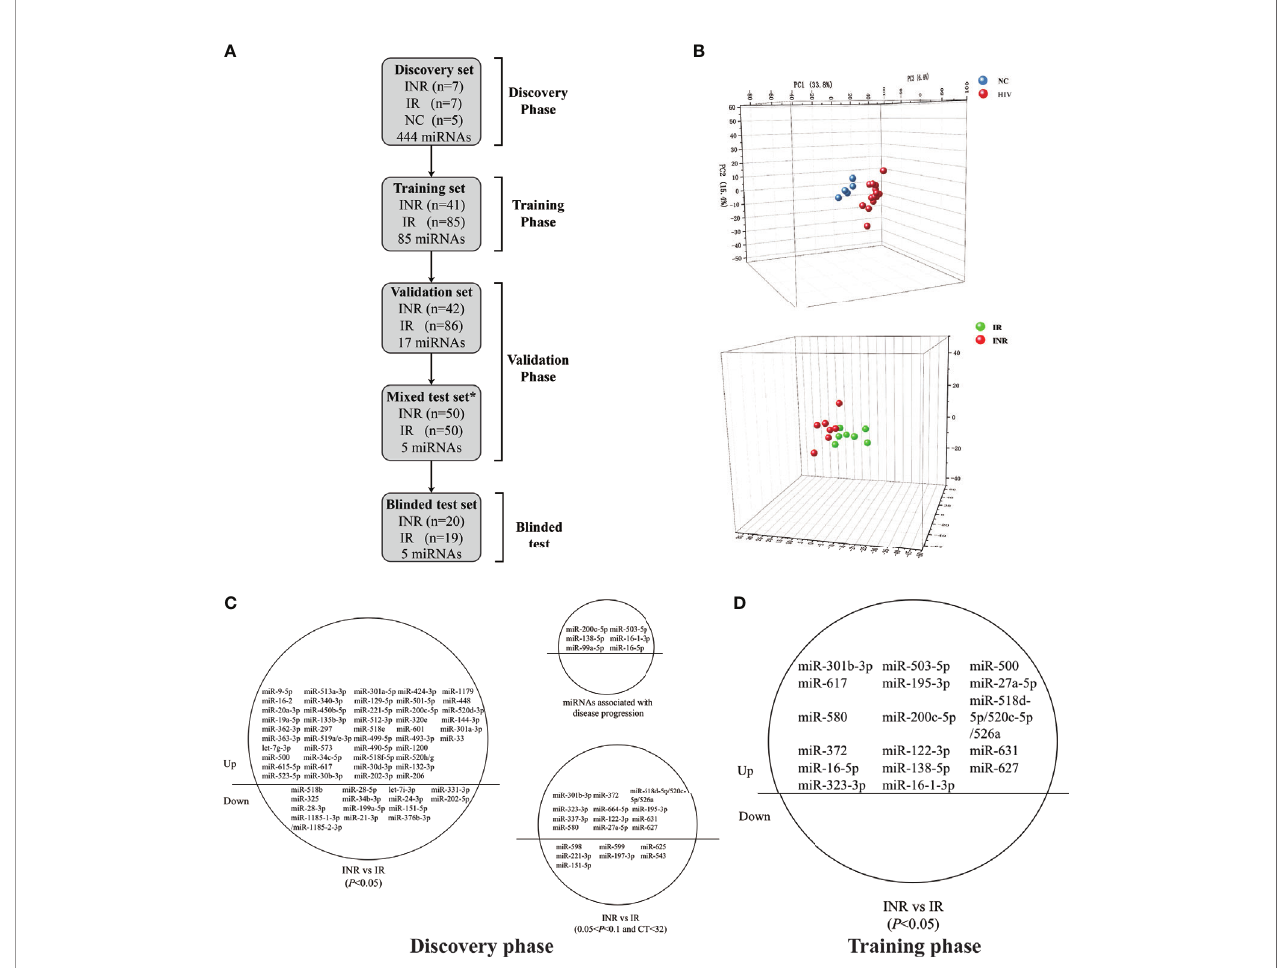
FIGURE 1 | Circulating microRNA (miRNA) levels can predict differences in the extent of immune reconstruction after antiretroviral therapy (ART) in people with human immunode fi ciency virus (HIV) infection. (A) Diagram of sample collection and miRNA screening in the four phases of our study. Plasma miRNA expressions of immune non-responders (INRs, n = 110), immune responders (IRs, n = 197), and HIV-negative controls (NCs, n = 5) were detected in the discovery, training, validation, and blinded test phases using fl uorescent reverse transcriptase- quantitative polymerase chain reaction (RT-qPCR). *Samples in the mixed test set were obtained from the training and validation set. (B) Principal components analysis (PCA) of 60 differentially-expressed miRNAs from INRs, IRs, and NCs in the discovery phase. (C) The 60 differentially-expressed miRNAs ( p < 0.05), 19 miRNAs (0.05 < p < 0.1, CT < 32) and six reported miRNAs chosen for evaluation in the training phase. (D) The 17 miRNAs signi fi cant differential expressed ( p < 0.05) between IRs and INRs from the training